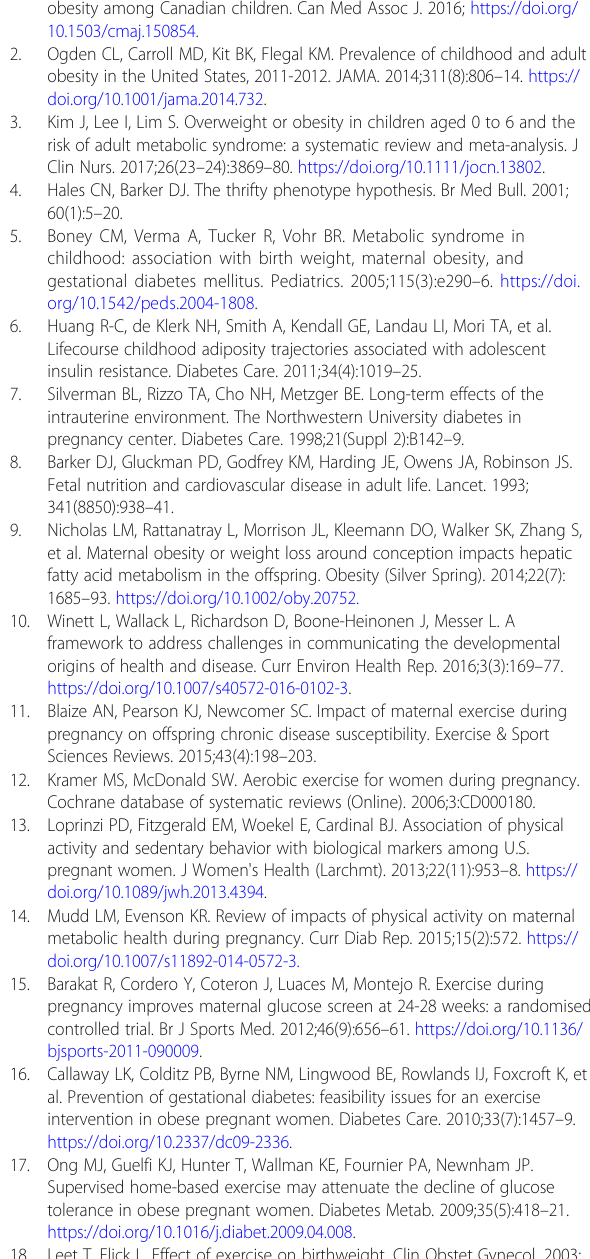
standardized mean difference. The vertical axis represents the standard error of the mean. Individual study results are represented by the open circles. The vertical line in the plot represents the pooled effect size. The poor symmetry specifically in smaller studies might indicate a publication bias favoring studies that found a reduction in birth weight following prenatal exercise. (EPS 77 kb) Additional file 2: Figure S2. Summary of risk of bias for individual studies following the Cochrane tool. Low risk of bias is indicated by the plus sign, high risk of bias by the minus sign and unclear risk of bias by the question mark. (EPS 980 kb) Additional file 3: Figure S3. Summary of risk of bias for individual studies following the Risk Of Bias In Non-randomized Studies of Interventions tool. The possible categories of risk of bias are: Low (green), Moderate (Mod; blue), Serious (red), Critical (gray), and No information (NI; yellow). (TIF 111 kb) Abbreviations BMI: Body mass index; CI: Confidence interval; LGA: Large for gestational age; MD: Mean difference; RCT: Randomized controlled trials; RR: Risk